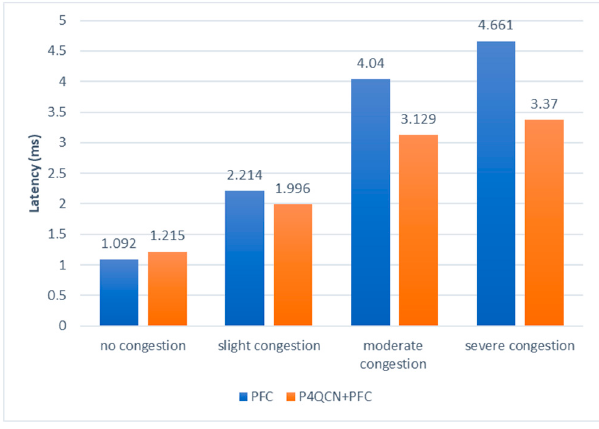
Figure 15. Latency comparison of PFC and P4QCN + PFC.